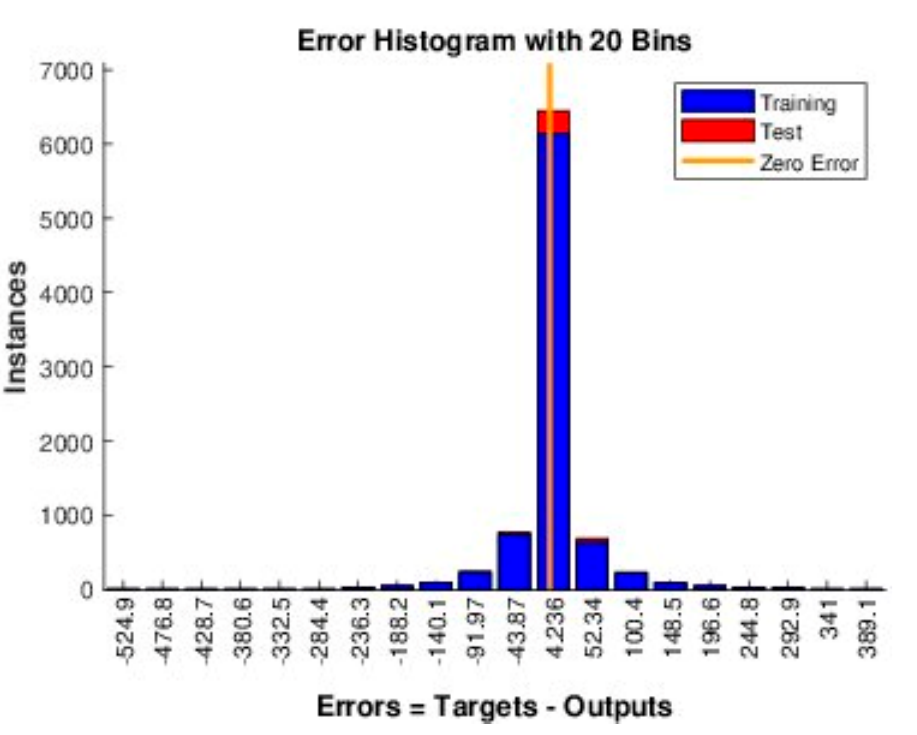
Figure 14. Error histogram plot of neural network (solar irradiance forecasting case).